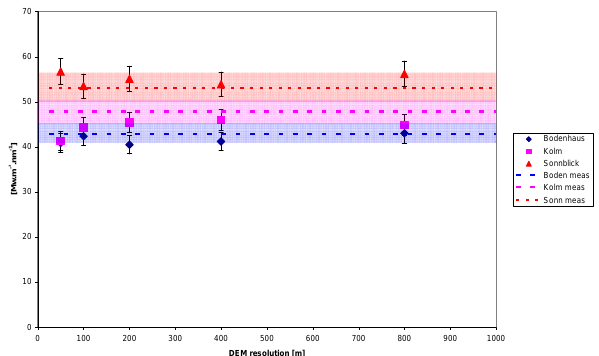
Fig. 13. Modeled 3-D UV irradiance (305nm) calculations for 7 May, 12:00 UTC as a function of DEM resolution. Dotted lines show the measurements which correspond to the locations and the time of calculation. Solar zenith angle is 32.77 degree. The shapes show the model results (diamond=Bodenhaus, square=Kolm Saigurn, triangle=Sonnblick). The error bars show the accuracy of the model simulations ( ± 5%). The coloured areas around the lines of measurements indicate the measurement uncertainty (= ± 5%).